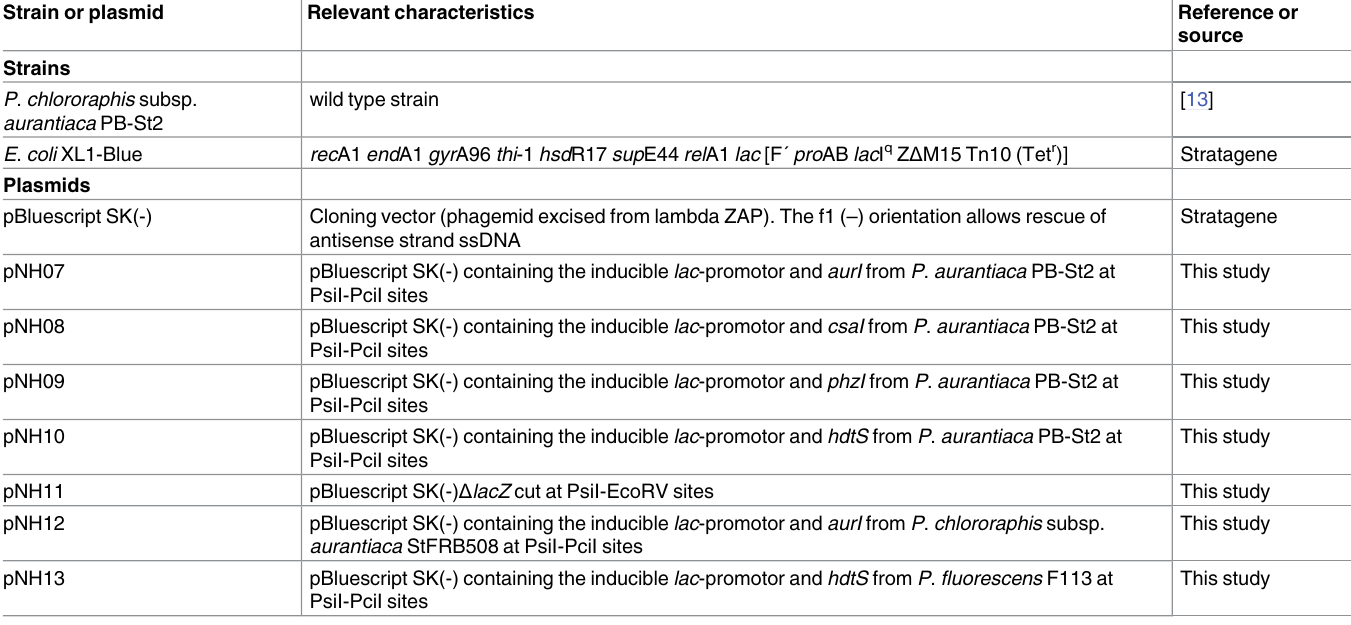
Table 1. Bacterial strains, plasmids, and primers used in this study. Strain or plasmid Relevant